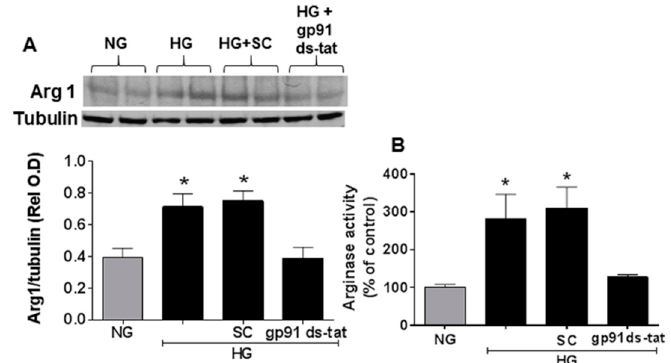
Figure 6. NOX2 blockade prevents high glucose-induced increases in arginase 1 expression and arginase activity in retinal endothelial cells. Western blot and quantitation showing effects of the NOX2-blocking peptide gp91ds-tat on expression of arginase l (Arg1) protein ( A ) and arginase activity ( B ) in endothelial cells treated with high glucose (HG). HG substantially increased arginase 1 expression and arginase activity as compared to the normal glucose (NG) controls. These increases were blocked by bp91ds-tat but were not altered by the scrambled control (SC) peptide. * p < 0.05, n = 3–4.